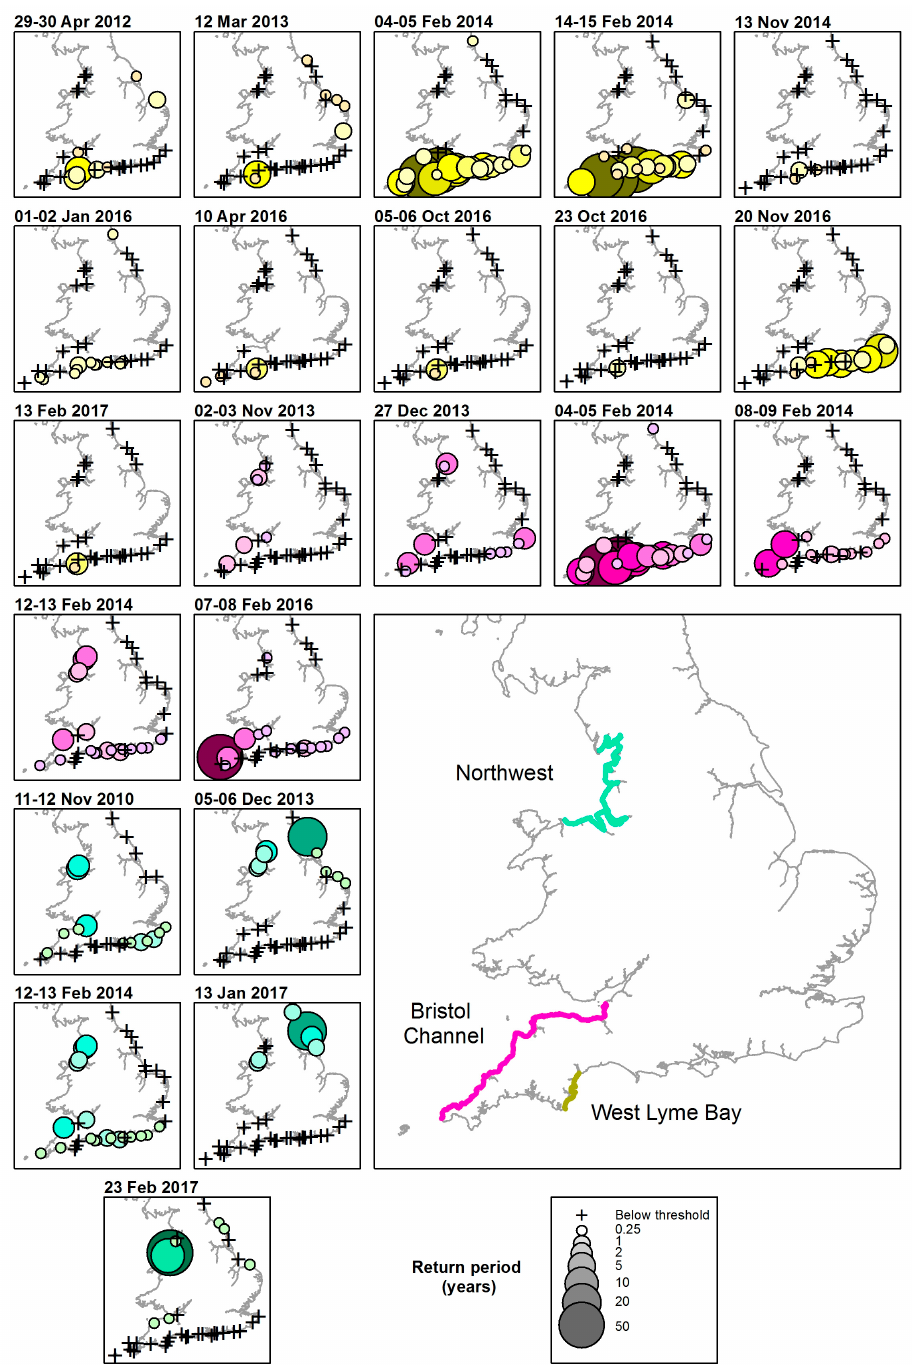
Figure 4. Spatial footprints of extreme wave events affecting at least two sites in the Bristol Channel and Northwest areas, and one site in West Lyme Bay. and Northwest areas, and one site in West Lyme